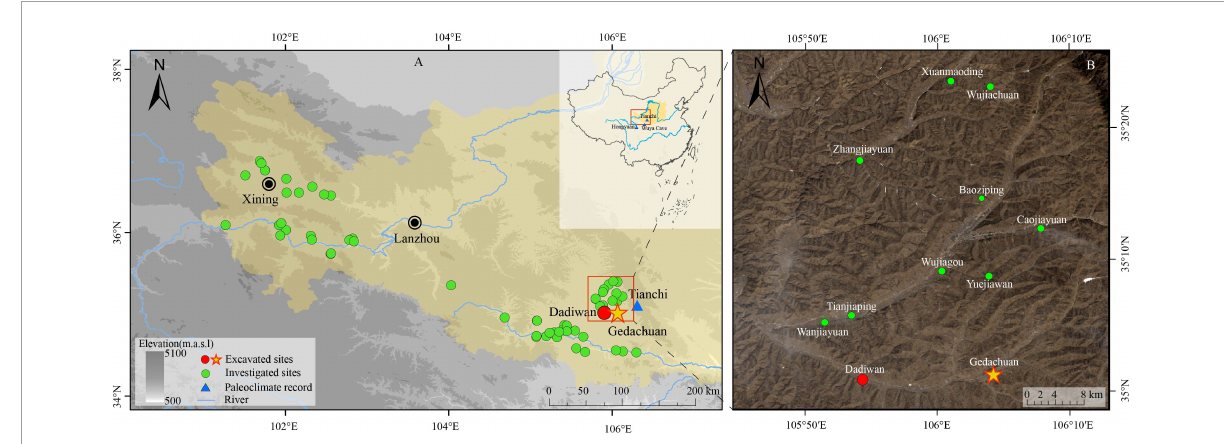
FIGURE1 The distribution of survey and excavation sites in the WLP from 8,000 BP to 4,000 BP. (A) The distribution of survey and excavation sites in the WLP. (B) The distribution of Gedachuan site and its adjacent Zhuanglang county survey sites.